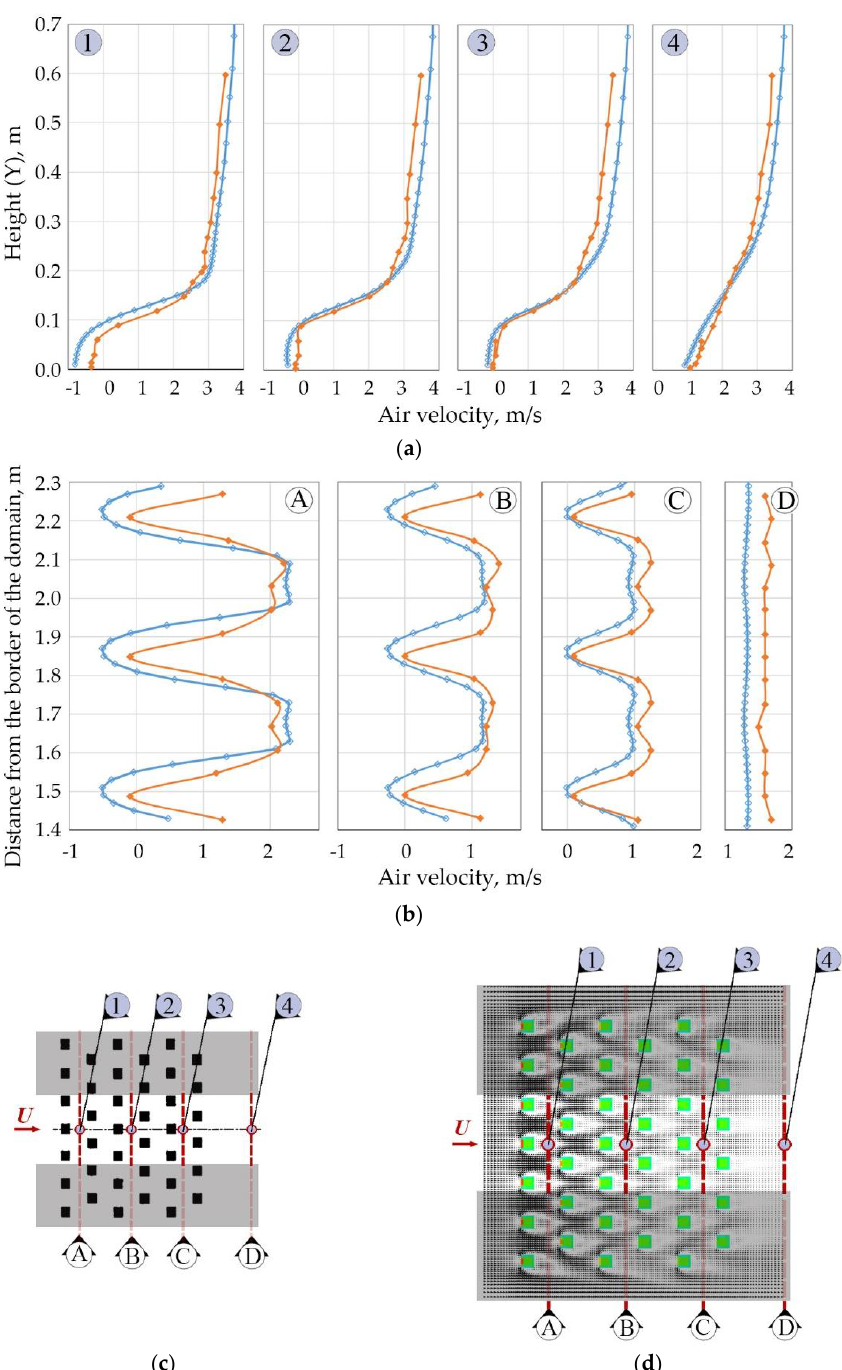
Figure 6. Vertical ( a ) and horizontal ( b ) air velocity profiles obtained by the CFD validation model ( d ) based on the wind tunnel study ( c ) by Davidson et al . [21] ( wind tunnel experiment results, CFD prediction results).